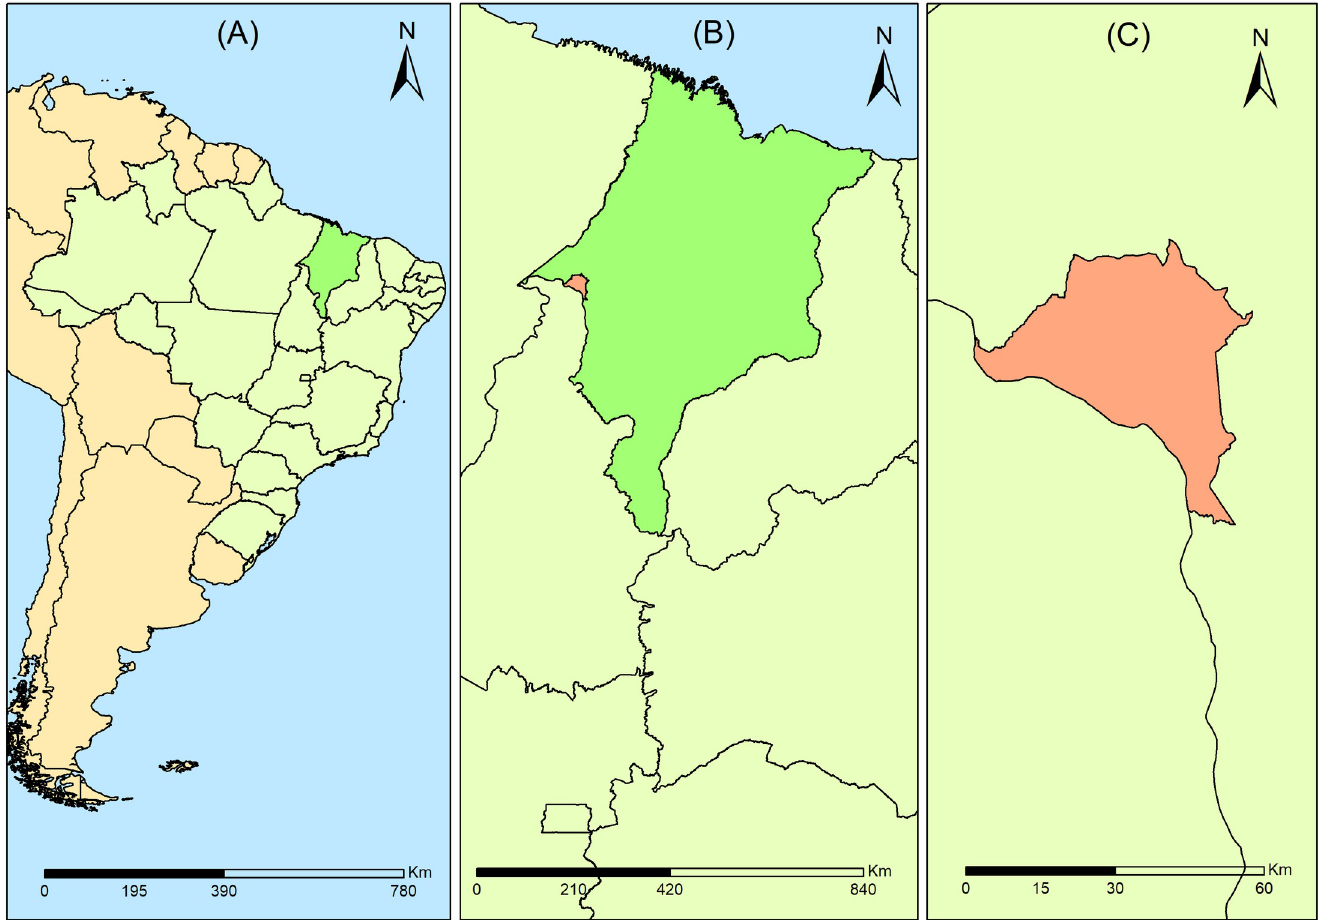
Fig 1. Location map of the study setting, Imperatriz, MA, Brazil. (A) Brazil; (B) State of Maranh ã o; (C) City of Imperatriz. Source: Authors.